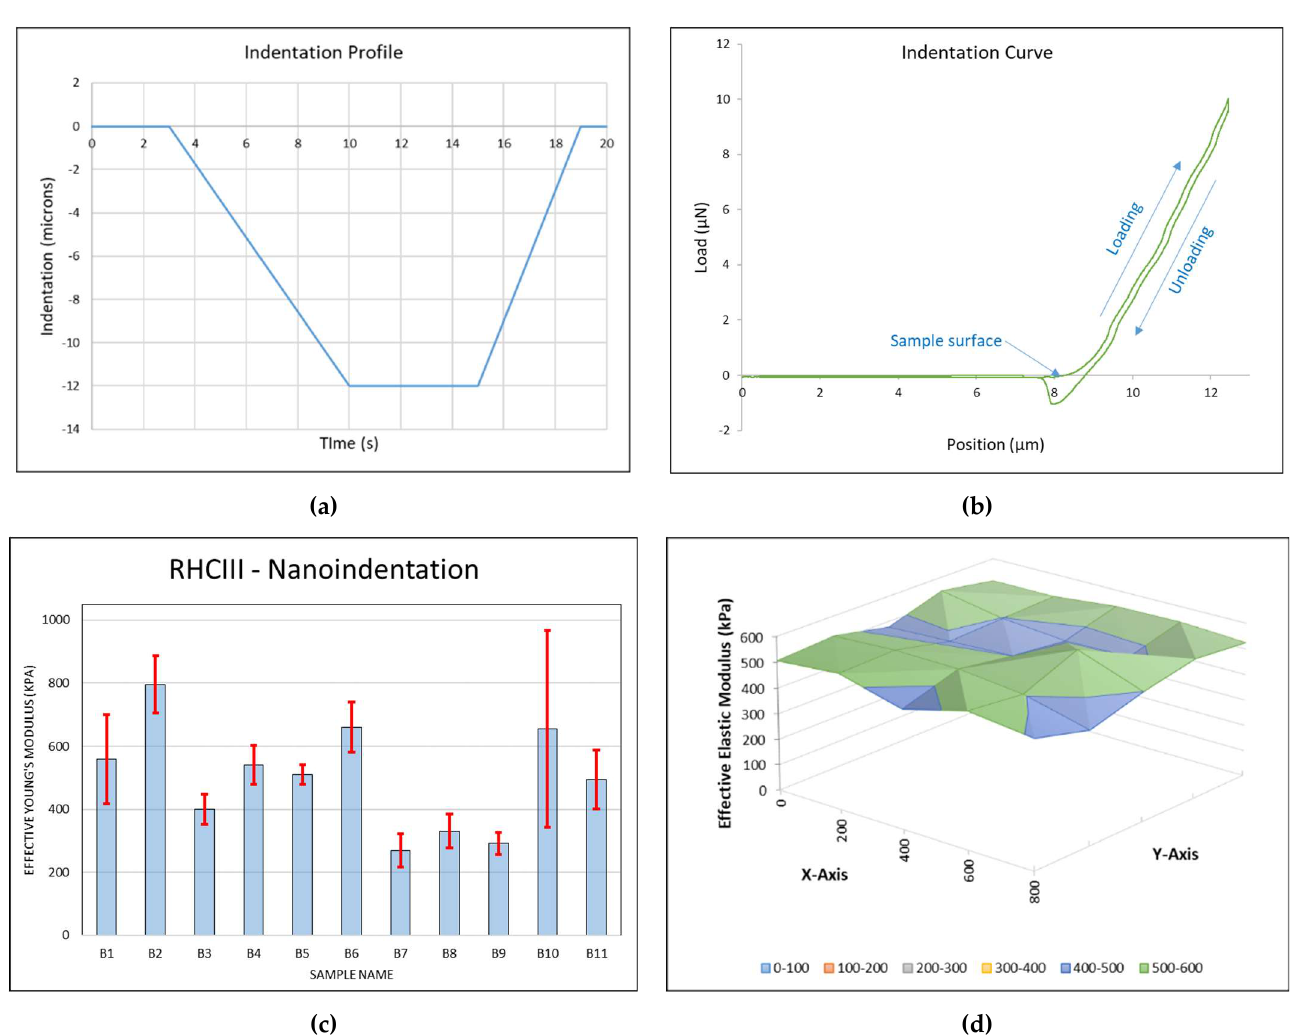
Figure 3. ( a ) The indentation profile used in the study which included an 8 µm off-set, so the sample was indented 4 µm. ( b ) The indentation curve illustrates the offset, with the load only increasing after the probe has moved 8 µm. The loading slope of the loading curve is used to calculate the elastic modulus. ( c ) The average effective E of each sample from 25 indentations with error bars representing the standard deviation. ( d ) An effective E map of sample B5 representing the 800 µm × 800 µm 25 point indentation matrix with 200 µm between indentations.